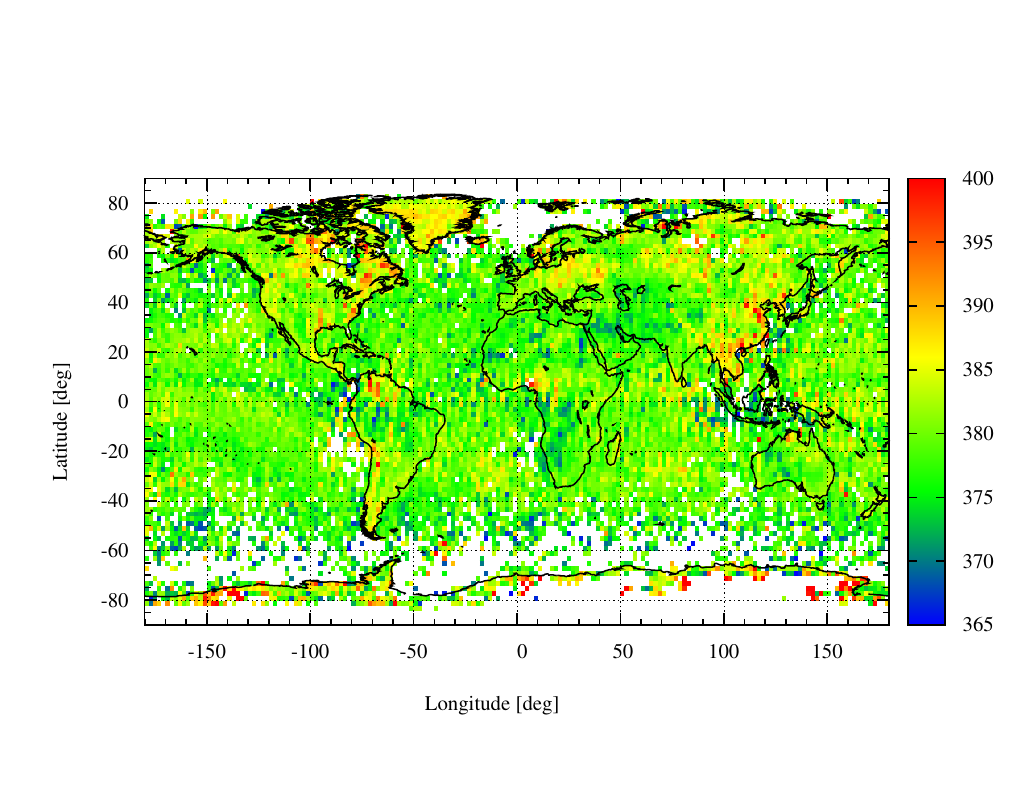
Figure 1: Global map of XCO 2 retrieved from IASI measurements with KLIMA code yearly averaged over a 2 ◦ x 2 ◦